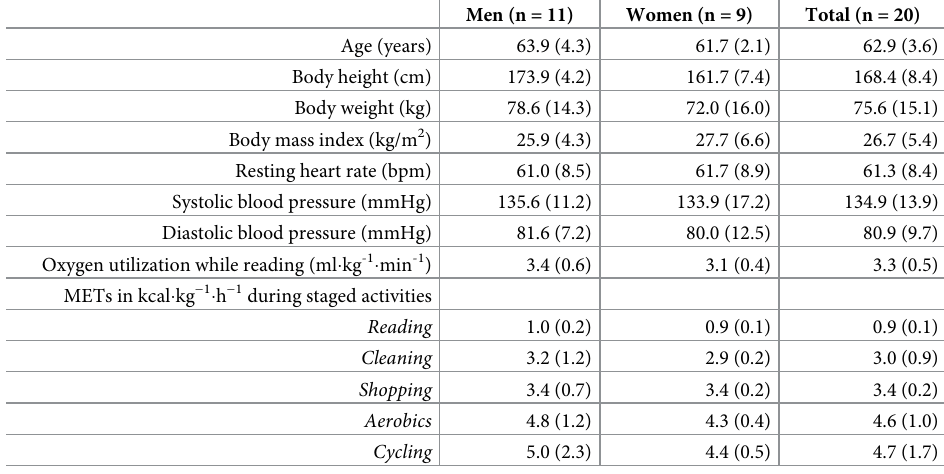
Table 1. Description of the study sample (means and standard